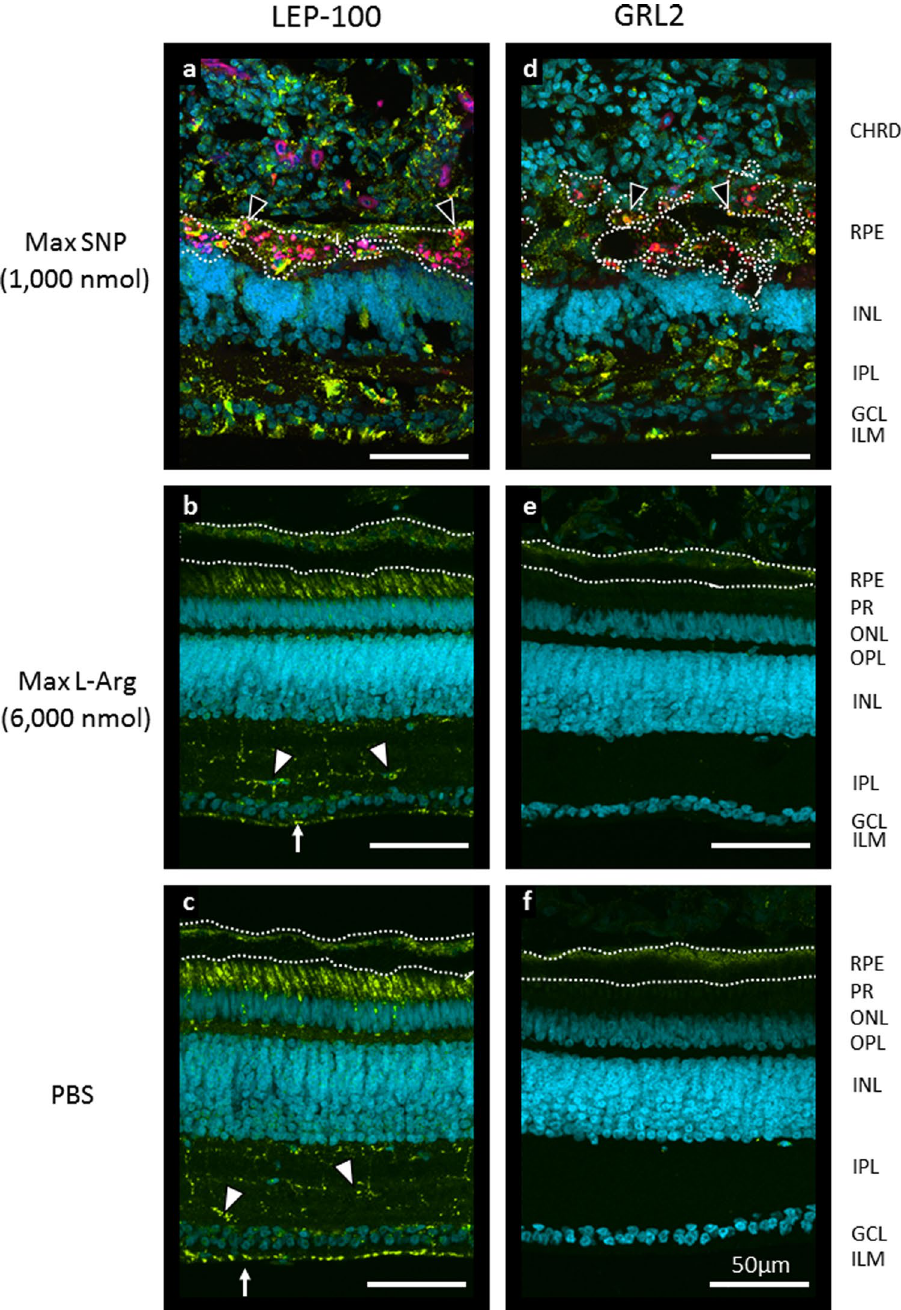
Figure 4. Fluorescence micrographs of retinal sections, labeled yellow-green for LEP-100 or GRL2 and teal- blue for nuclei (DAPI); RPE and pigmented structures, which we located in bright-field images, are outlined with white dotted lines. In retinas treated with the maximal dose of SNP ( a , d ), intense LEP-100 and GRL2 signals were found in the IPL, near the inner limiting membrane, and in the choroid; a significant amount of red autofluorescence (pseudo-colored pink) was detected in what are most likely the pigmented remnants of the RPE, some of which were co-localized with the LEP-100 and GRL2 signals ( ▼ ). In all other tissues tested, there was no significant fluorescence in the red channel, and LEP-100 and GRL2 labelling patterns did not differ according to treatment group. LEP-100 signal was present in the basal RPE, bacillary layer (PR), putative microglia/macrophage in the IPL ( ▽ ), and probable astrocytes at the internal limiting membrane ( ) in max L-Arg- and PBS-treated retina ( b , c ). GRL2 signal was not detected in undamaged retina ( e , f ). Abbreviations: CHRD [choroid]; RPE [retinal pigment epithelium]; PR [photoreceptor inner and outer segments (bacillary layer)]; ONL [outer nuclear layer]; OPL [3outer plexiform layer]; INL [inner nuclear layer]; IPL [inner plexiform layer]; GCL [ganglion cell layer]; ILM [inner limiting membrane]. Images are maximum-intensity Z-stack projections of the entire thickness of retinal sections (12–14 µ m, 1.5 µ m/slice); scale bar = 50 µ